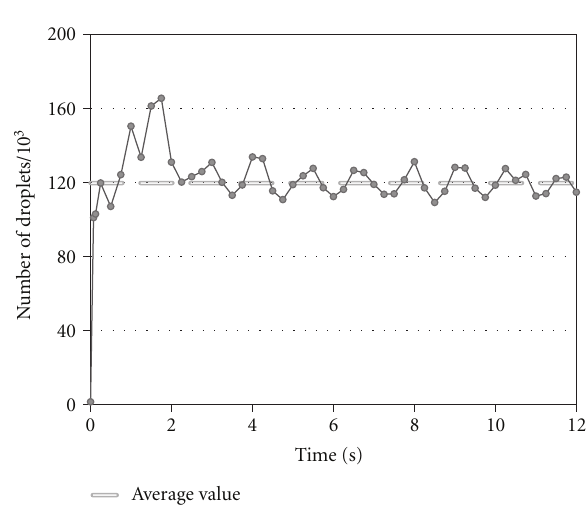
Figure 6: Instantaneous number of